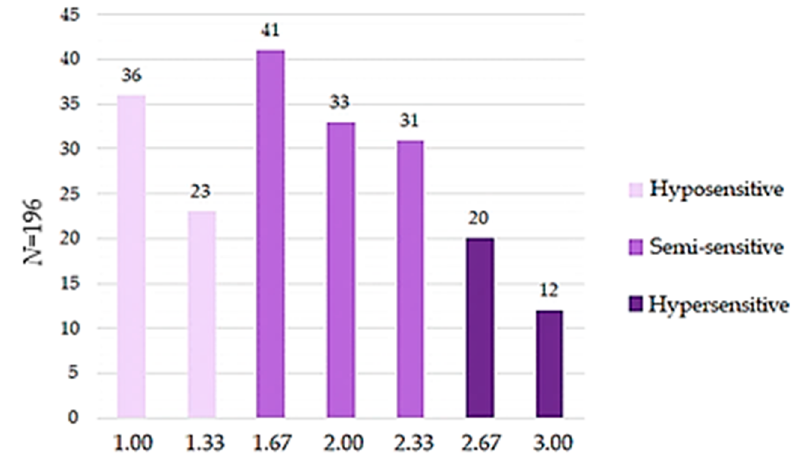
Figure 1. The participants were divided into different sensitivity groups (Hyposensitive N = 59, Semi-sensitive N = 105, and Hypersensitive N = 32), based on their oral chemesthesis sensitivity score (CSS) value presented in X-axis. The number of participants in each group is shown in the Y-axis.